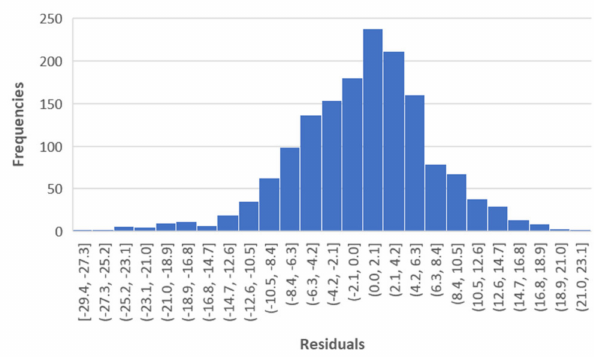
Figure A2. Normality probability histogram for regression model